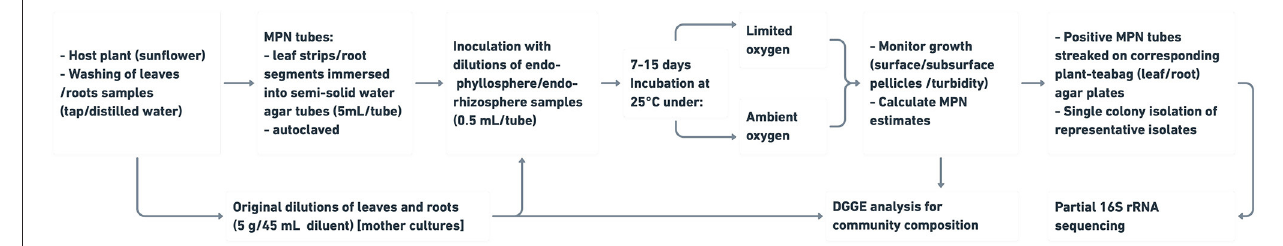
FIGURE 1 | Workflow of compatible plant organ (leaf strips/root segments)-culturing strategy of bacterial endophytes residing endo-phyllosphere and endo-rhizosphere of plants.